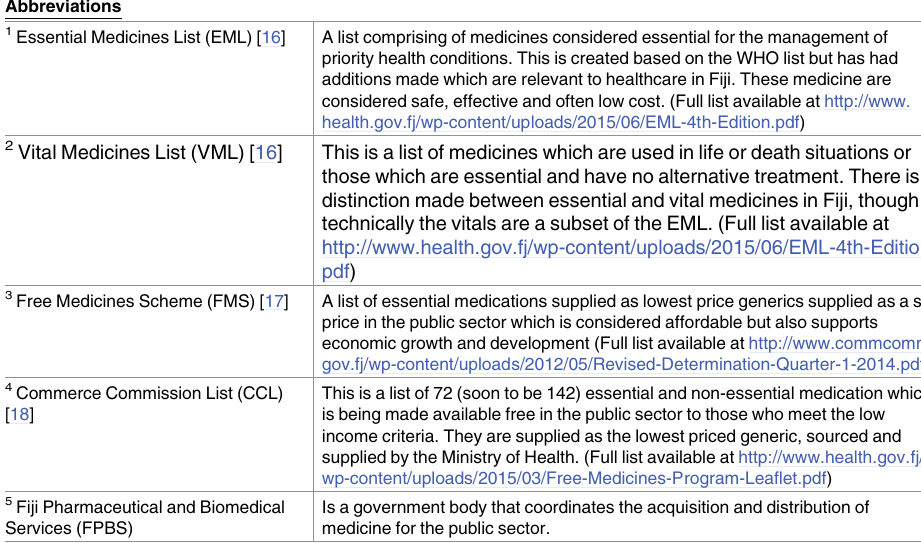
Table 1. The common medicine accessschemes in